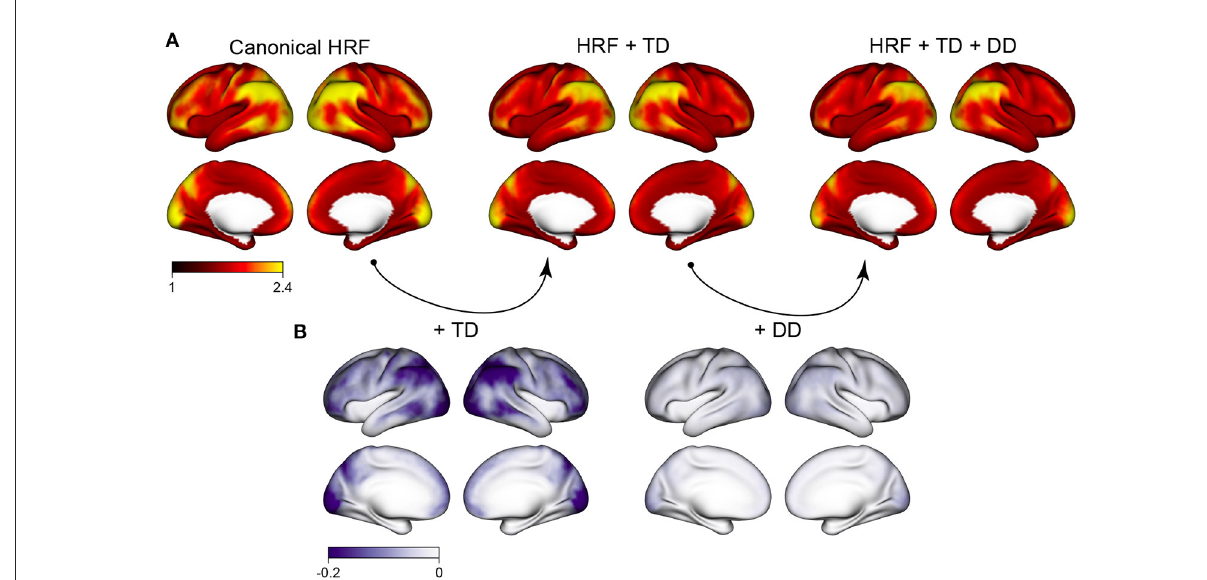
FIGURE1 Spatial patterns of autocorrelation and the effect of HRF modeling. (A) The average autocorrelation index (ACI) across all subjects, sessions and tasks, for three different cases: assuming a canonical HRF, including the HRF temporal derivative (TD) to allow for differences in HRF onset; and including the HRF TD and dispersion derivative (DD) to allow for differences in HRF onset and duration. (B) The reduction in ACI when HRF derivatives are included to allow for differences in HRF shape. Including the HRF TD has a sizeable effect in reducing autocorrelation; additionally including the HRF DD has a more subtle